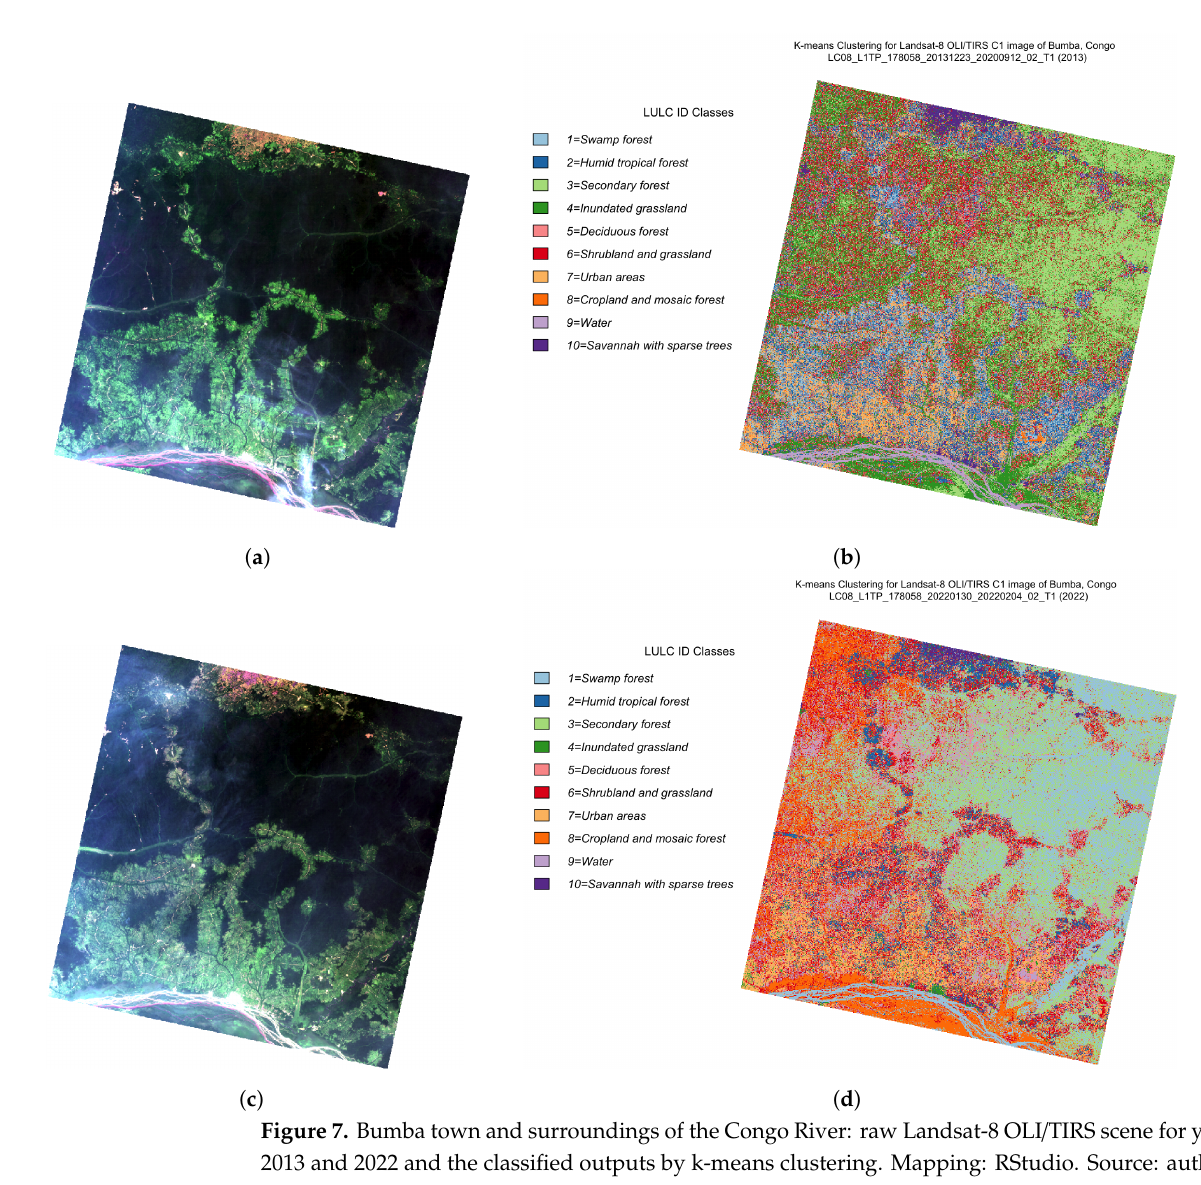
Figure 7. Bumba town and surroundings of the Congo River: raw Landsat-8 OLI / TIRS scene for years 2013 and 2022 and the classified outputs by k-means clustering. Mapping: RStudio. Source: authors. ( a ) Monochrome image for Bumba region: 2013. ( b ) Classified scene using k-means clustering: 2013. ( c ) Monochrome image for Bumba region: 2022. ( d ) Classified scene using k-means clustering: